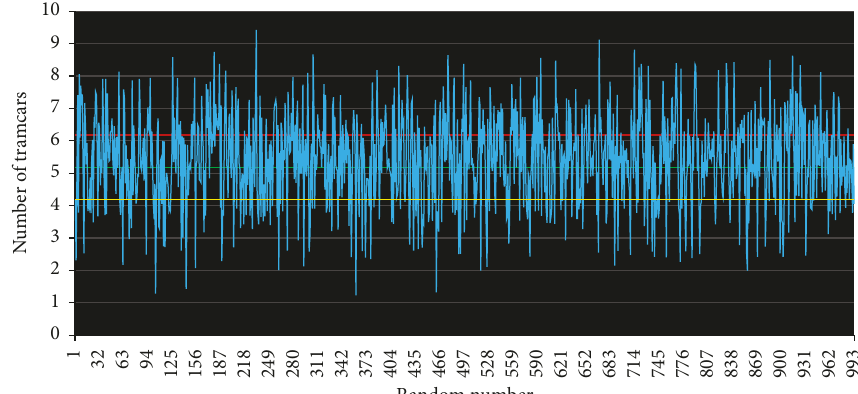
Figure 6: Simulation output and optimization solution at Haya Hulet 1 station, in the West to East direction, and in the afternoon shift.